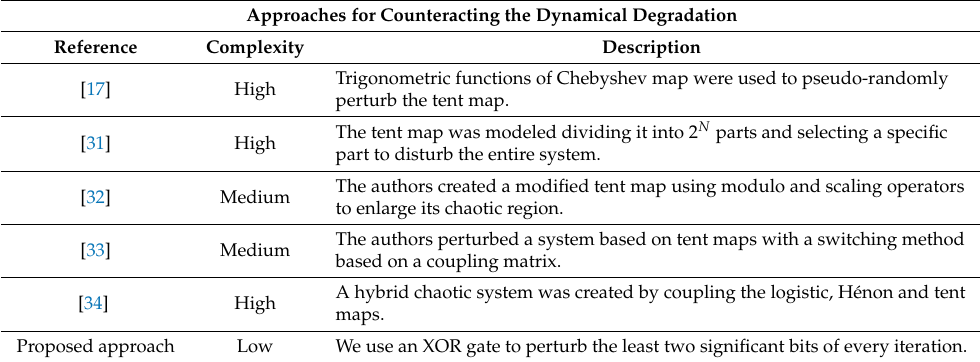
Table 1. Approaches for counteracting the dynamical degradation in the tent map.